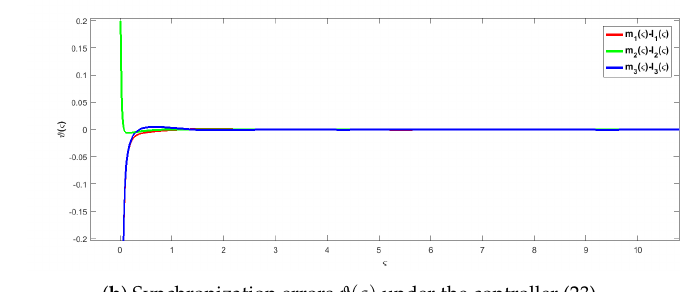
Figure 1. Fixed-time synchronization of “Chua’s circuit”.